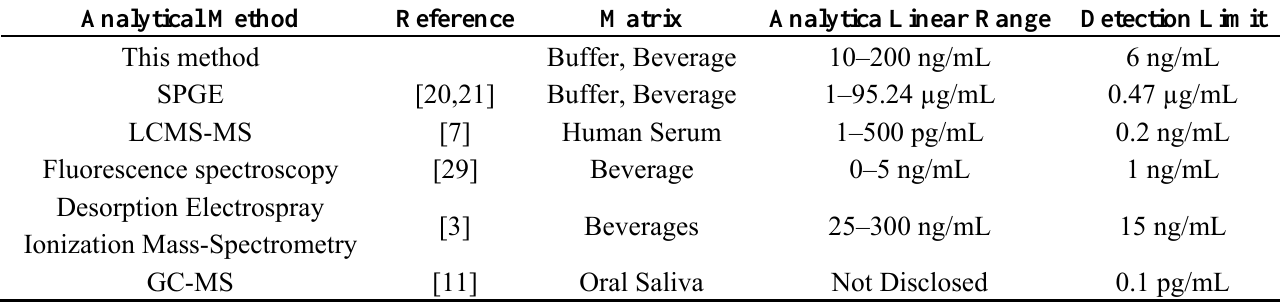
Table 1. Summary of various analytical techniques which have been reported for the determination of Rohypnol in different solutions.